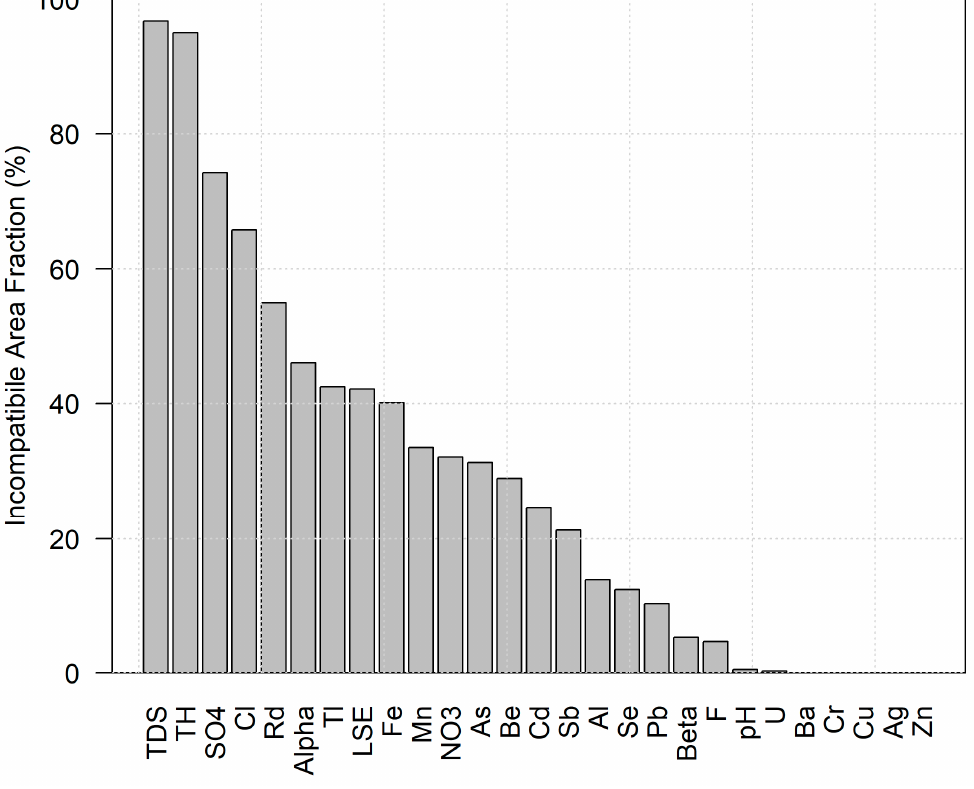
Figure 3. Fraction of incompatibility per constituent of concern for municipal water use.